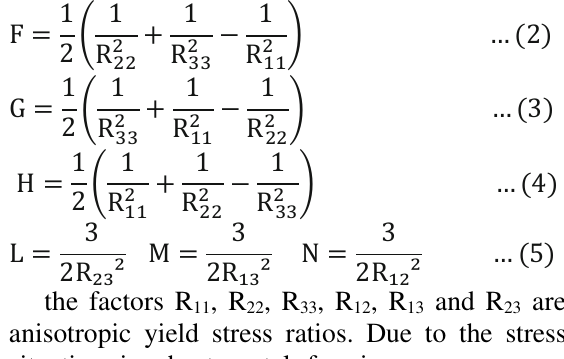
Fig. 4. Engineering Stress-Strain for SS304.